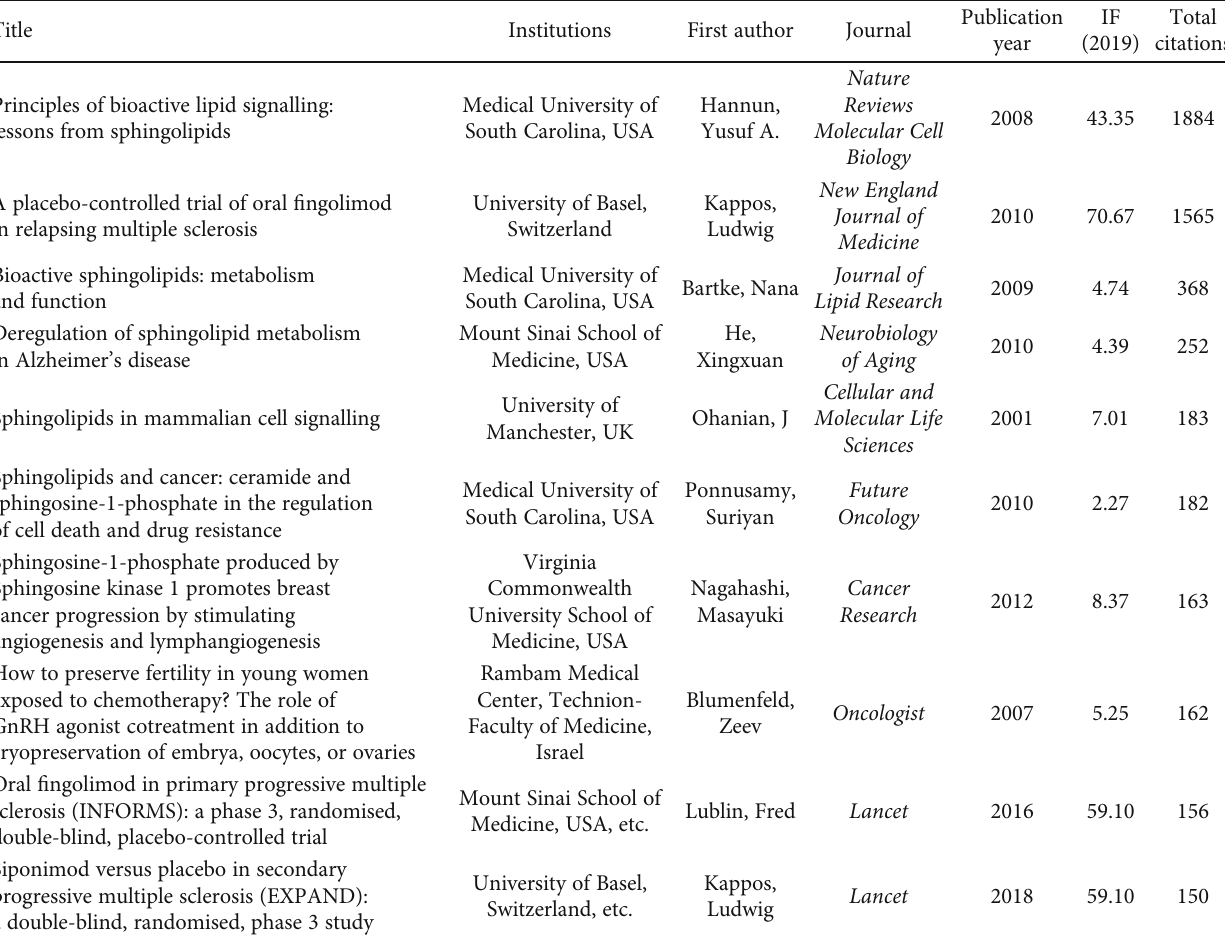
Table 2: Top 10 most cited